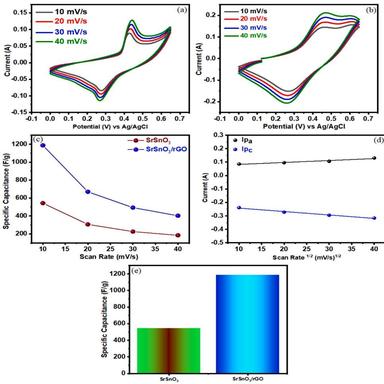
(a) CV of SrSnO3, (b) CV of SrSnO3/rGO nanohybrid, (c) Specific capacitance of SrSnO3 and SrSnO3/rGO nanohybrid, (d) Anodic and cathodic current of SrSnO3/rGO nanohybrid and (e) Comparison between SrSnO3 and SrSnO3/rGO nanohybrid.